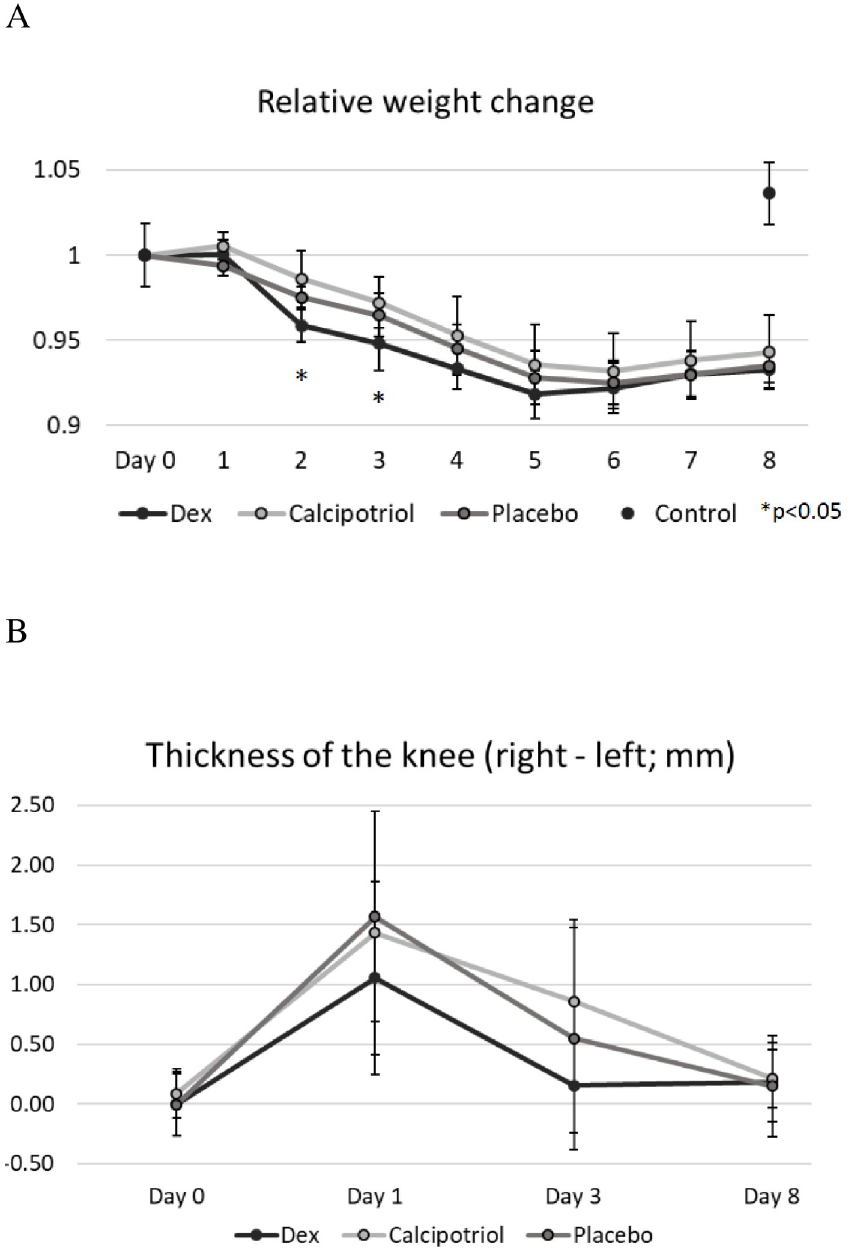
Fig 1. The relative average body weights (A) and knee joint swelling (right-left knees) of the arthritic rats during the experiment. Zymosan was injected on day 0 and the study compounds on day 1. (A) The relative weight reduction ((day X-day 0)/100) was significantly greater in the dexamethasone group than in the vehicle group on days 2 and 3, (p = 0.003 and p = 0.02 respectively). (B) The effect of the study compound on knee joint swelling was measured as a difference in the medio-lateral diameter at the joint gap level between the right arthritic and the left control knee. The severity of the clinical arthritis measured by swelling did not differ between calcipotriol and vehicle groups or dexamethasone or vehicle groups on day 3 or 8 (p = ns). The non-significant difference on day 1 is likely due to chance as study compounds were administered after the measurement. The number of rats was eight in calcipotriol and vehicle groups, nine in dexamethasone group, and ten in the control group. The data are expressed as mean ± SD.